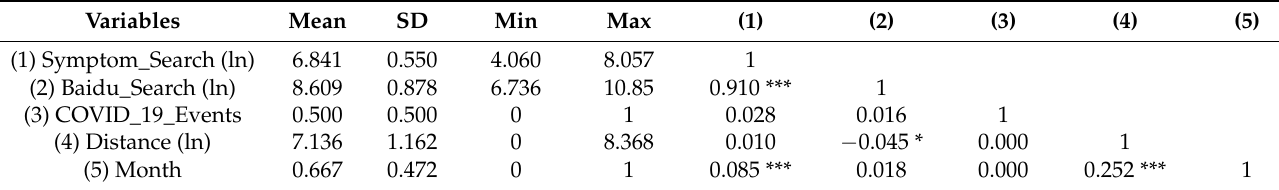
Table 2. Descriptive statistics and correlations.